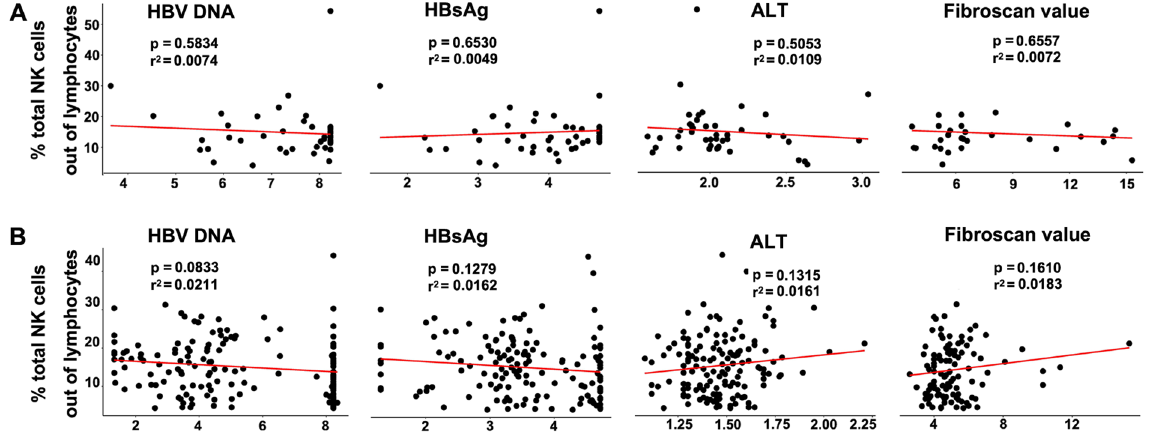
Figure 3. Correlations of clinical virology parameters with percentages of NK cells in CHB patients. Correlations of levels of HBV DNA, HBsAg, ALT and fibrosis, respectively, with NK frequency in patients in CA ( A ) and CAN ( B ) groups. Linear regression was used to explore the correlations. The fitted curve, p value and r 2 were